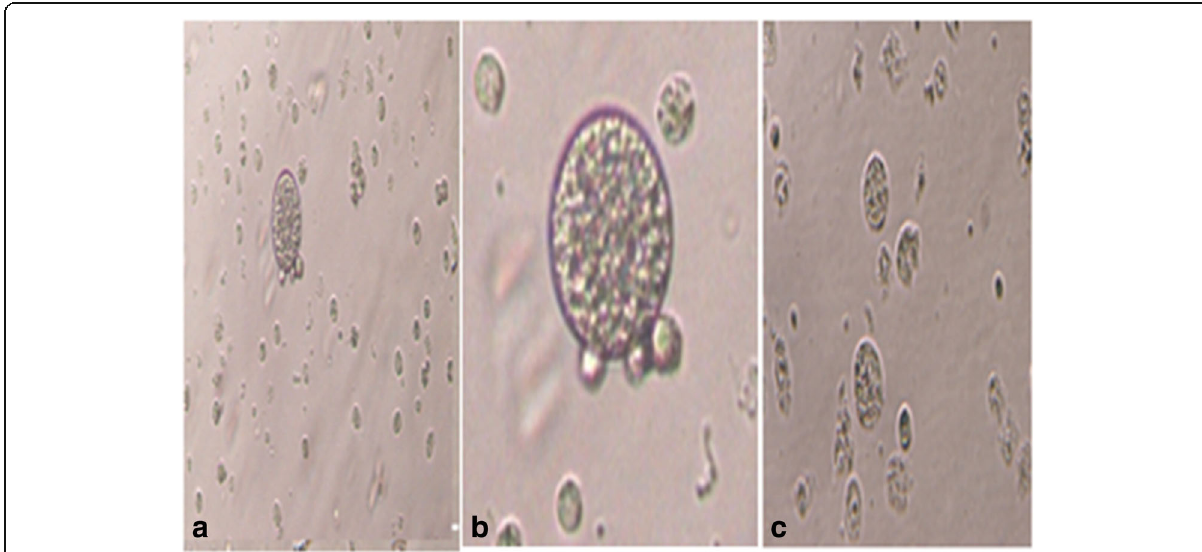
Fig. 1 Showing different sizes of bovine and buffalo preantral follicles. a and b represent healthy preantral follicles and c represent non-healthy (degenerated) preantral